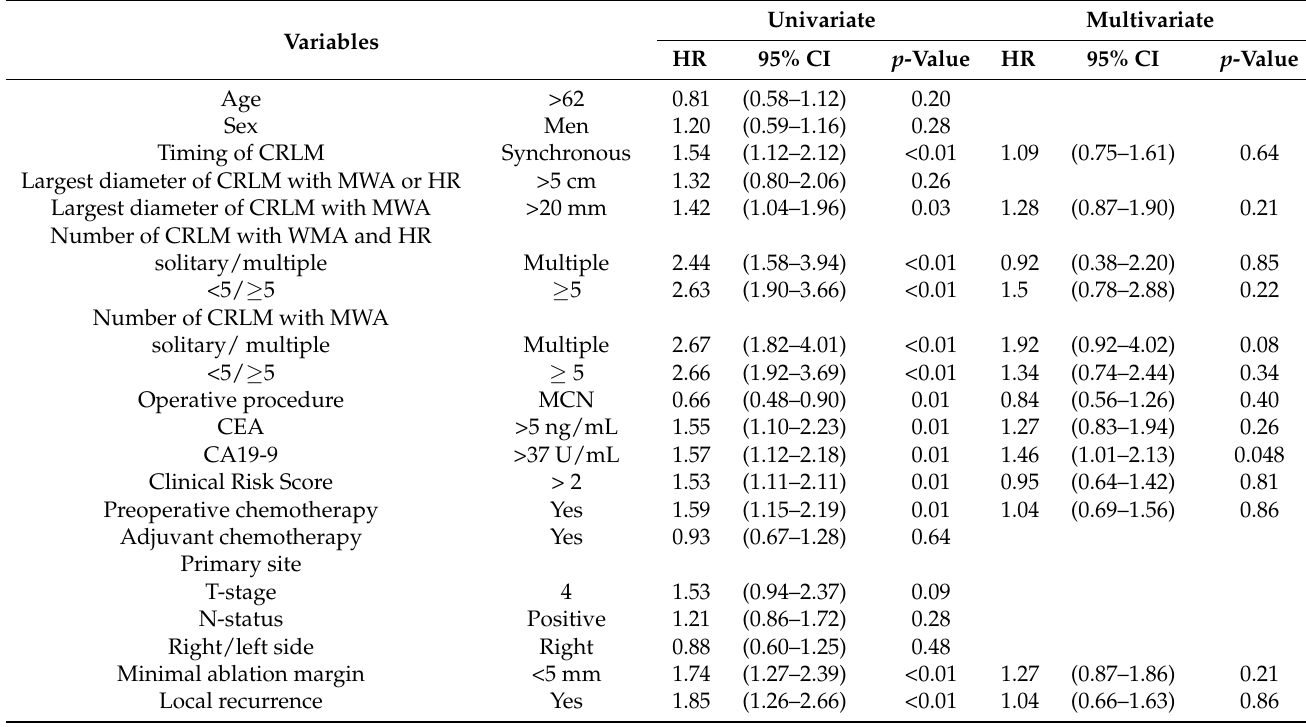
Table 5. Univariate and multivariate analysis of the prognostic factors for disease-free survival in patients with CRLM treated with MWA.